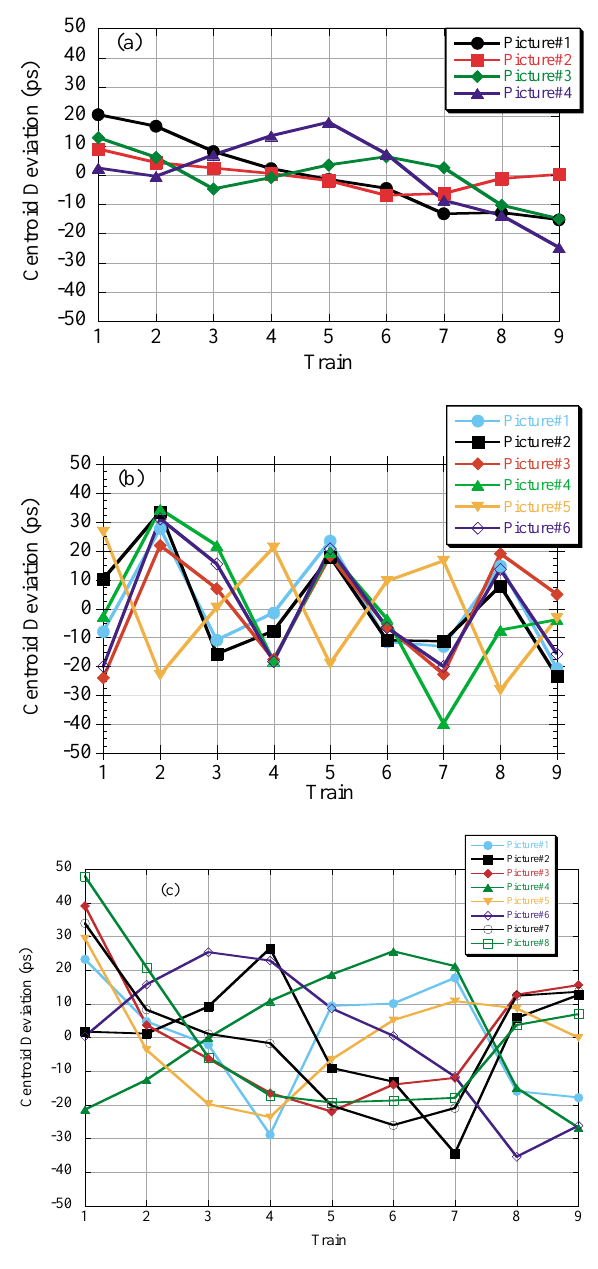
FIG. 27. (Color) The train centroid deviation for (a) four images of nine stable trains at 184 mA total current, (b) six images of unstable trains at I (cid:1) 184 mA total current, and (c) eight images of unstable trains at 324 mA total current.